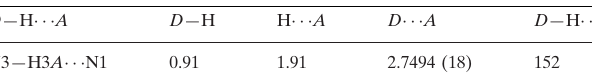
Hydrogen-bond geometry (A˚ , (cid:3)